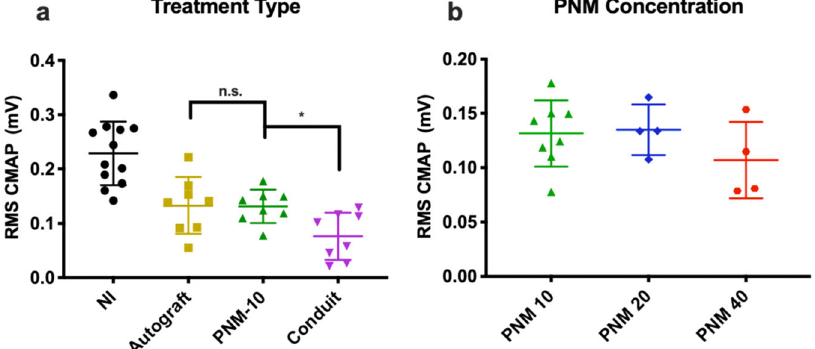
Fig. 5 Electrophysiological assessment was performed immediately prior to sacri fi ce at 24 weeks. a CMAP at 24 weeks comparing the treatment types. b CMAP at 24 weeks comparing the PNM groups. Data are presented as mean ± SD. P values <0.05 are denoted by *, p < 0.01 by **, p < 0.001 by ***, and p < 0.0001 by